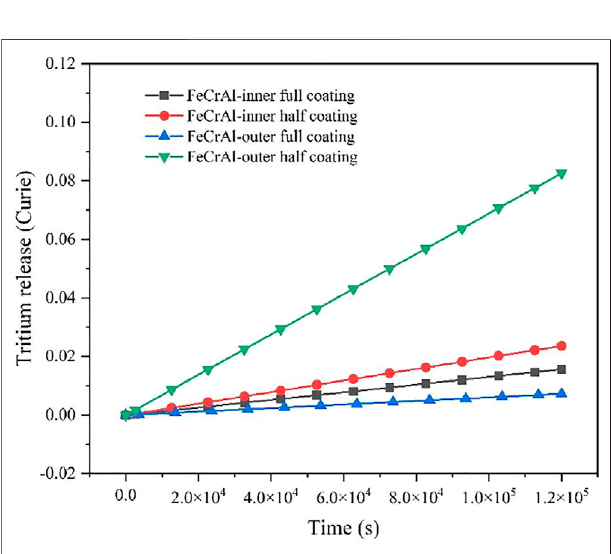
FIGURE 14 | Total amount of tritium released to the coolant for FeCrAl cladding with different coating scheme within 120,000 s.